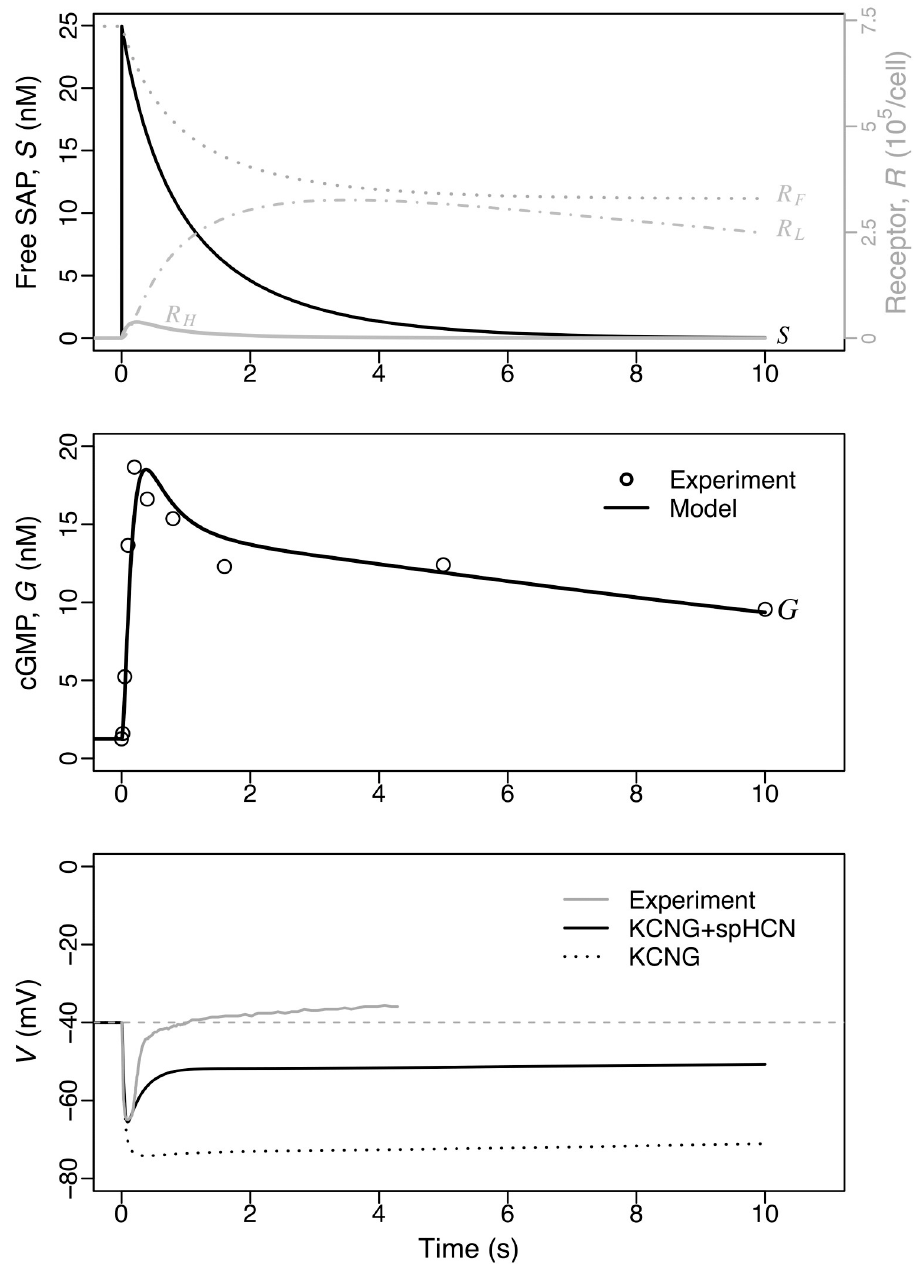
Fig 2. Numerical solution of the Upstream module overlaid with experimental data obtained in bulk sperm populations. The model with state space { S , R F , R H , R L , G , f o , f o , V }) was fitted to the cGMP concentration data kn hc measured on sperm populations stimulated at t = 0 with a SAP pulse S 0 = 25 nM (data points read from the graphs in publications [22] and [10] for cGMP and V , respectively; see also S5 Fig). In the top graph, receptor activation dynamics and SAP consumption are shown. The middle graph displays cGMP concentration dynamics in the model ( G , line) and the respective experimental measurements (dots) in nM. The bottom graph, shows two separate model solutions with KCNG+spHCN (solid black) and KCNG only (dotted; obtained by setting g hc=0 ). See main text for further details.